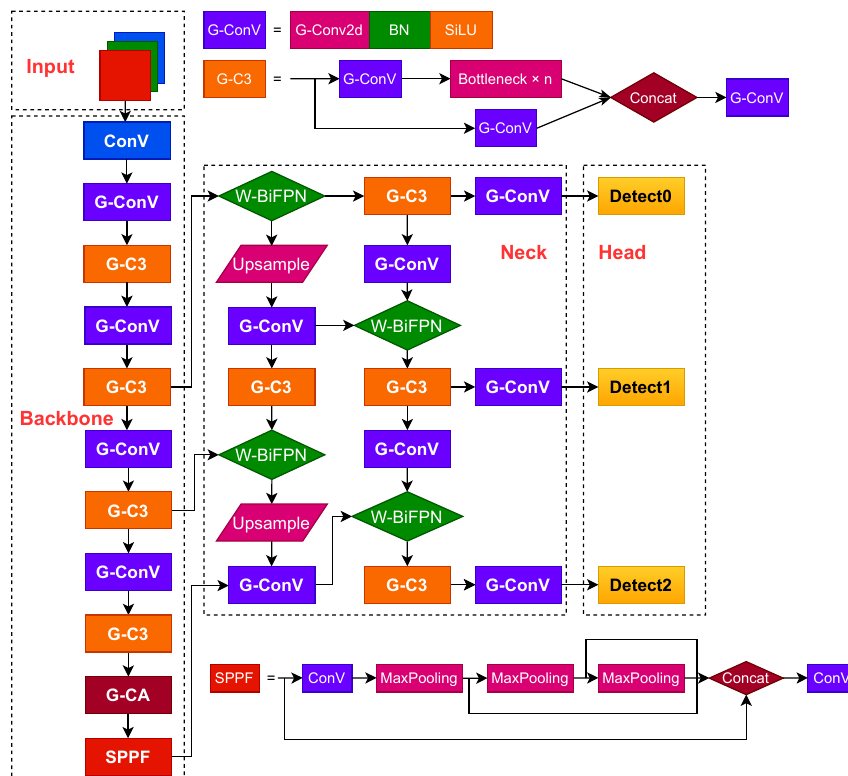
Figure 3. YOLOv5s-Z network